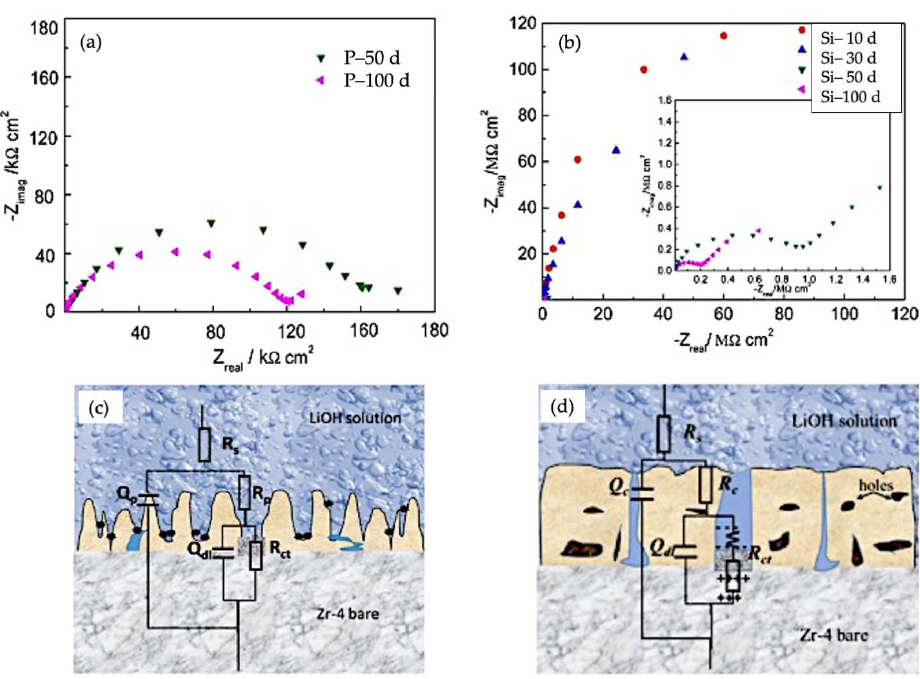
Figure 4. ( a , b ) Nyquist plots of EIS results of phosphate and silicate PEO coating for prolonged immersions, respectively [59]; ( c , d ) Equivalent circuit and physical model for phosphate and silicate PEO coatings after 50–100 days immersion, respectively [59] (Reproduced with permission number: 5043540272527, Elsevier).